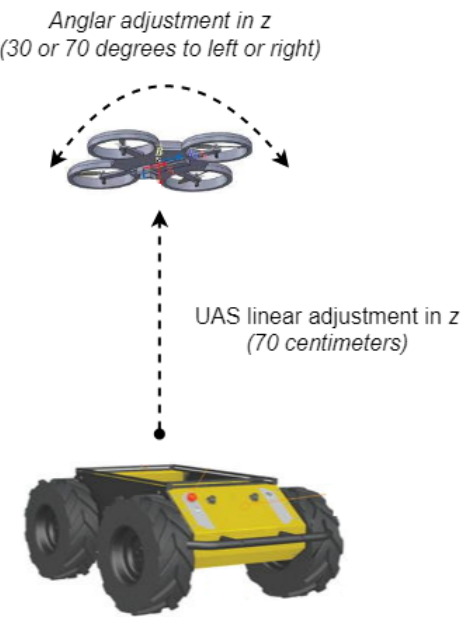
Figure 8. Overview of the UAS control strategy.